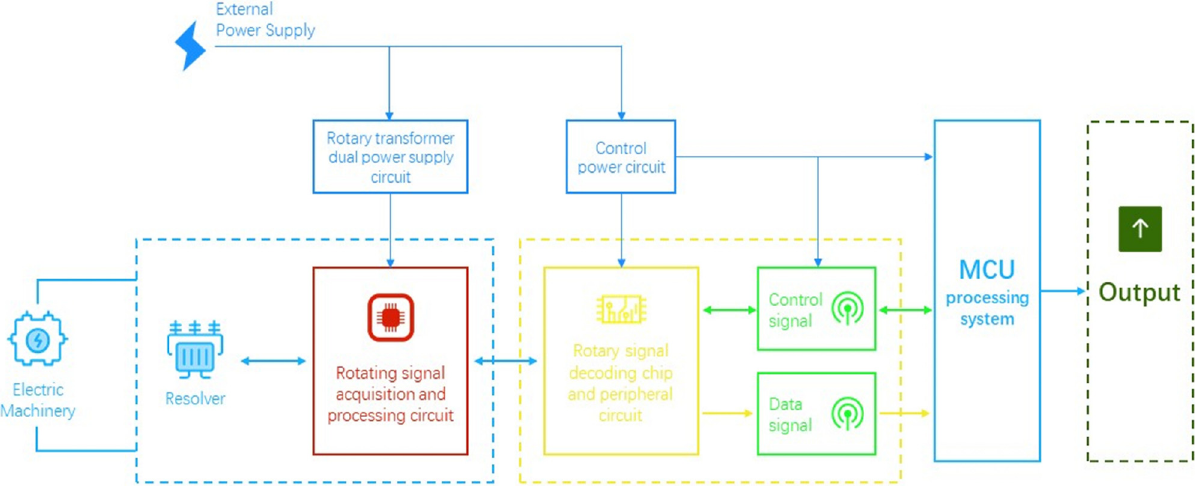
Figure 1: A kind of high - power mechanical equipment failure vibration signal